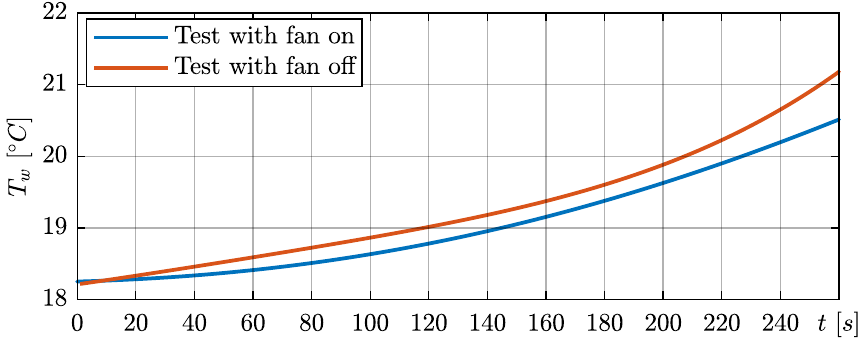
Figure 19. The winding temperature during proposed identification